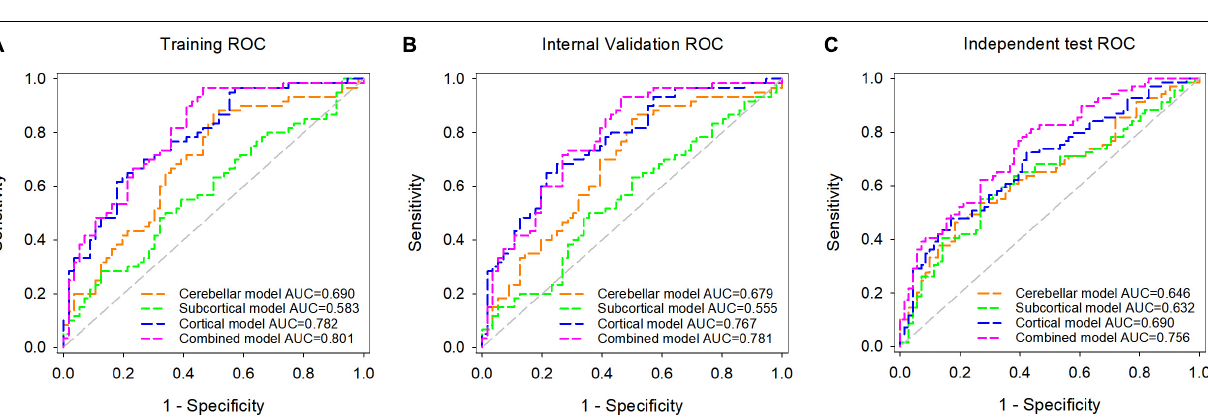
Frontiers in Aging Neuroscience |